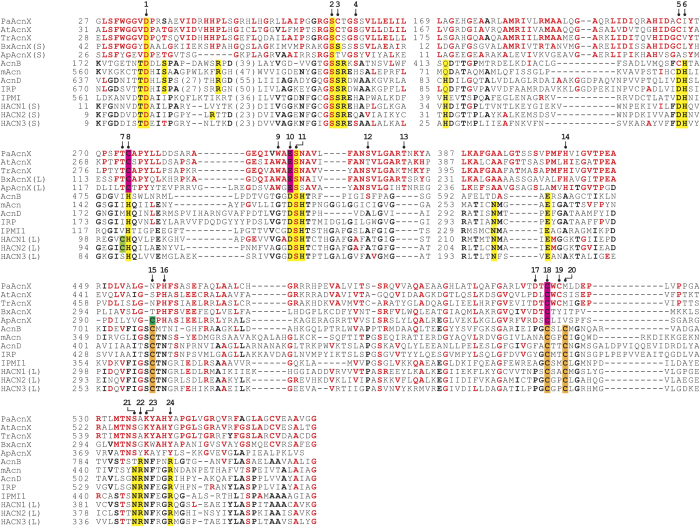
Partial multiple amino acid sequence alignments of AcnX and other Acn subfamilies.PaAcnX and AcnX from P. aeruginosa PAO1; AtAcnX, A. tumefaciens C58; TrAcnX, AcnX from T. reesei QM6a; BxAcnX, Burkholderia xenovorans LB400; ApAcnX, Aeropyrum pernix K1; AcnB from E. coli18; mAcn from bovine19; AcnD from Shewanella oneidensis MR-121; IRP from human20; IPMI from Saccharomyces cerevisiae26; HACN1 and HACN2 from M. jannaschii2342; HACN3 from Pyrococcus horikoshii OT343. “S” and “L” indicate small and large subunits, respectively. Red- and black-bold letters indicate amino acids highly conserved in the AcnX subfamily and Acn enzymes, respectively. The complete alignment of the AcnX subfamily is shown in Fig. S5.